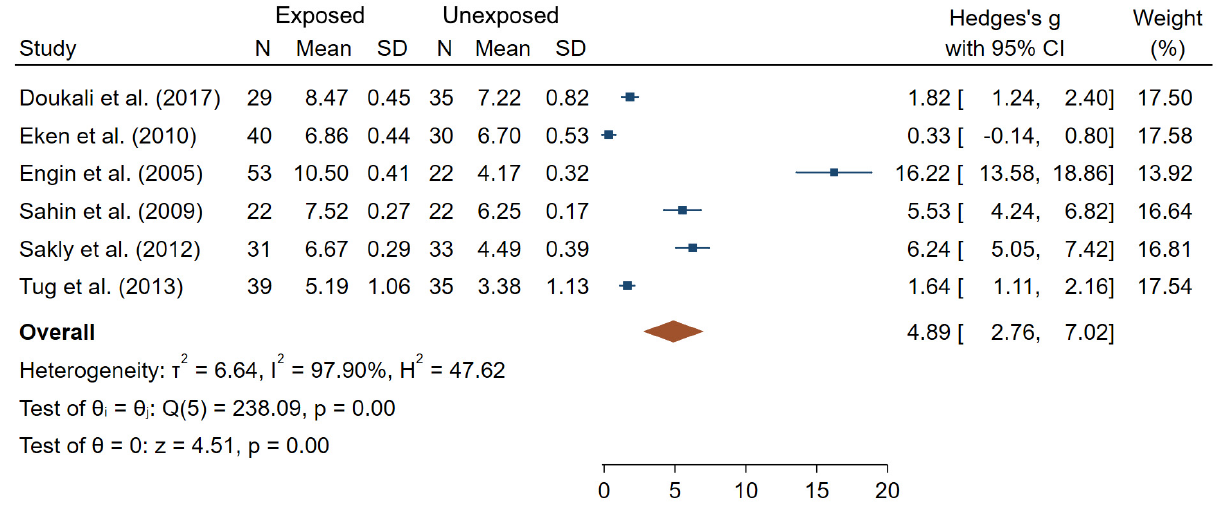
Figure 7. Forest plot of mean differences in SCE frequencies between IR exposed and unexposed workers.